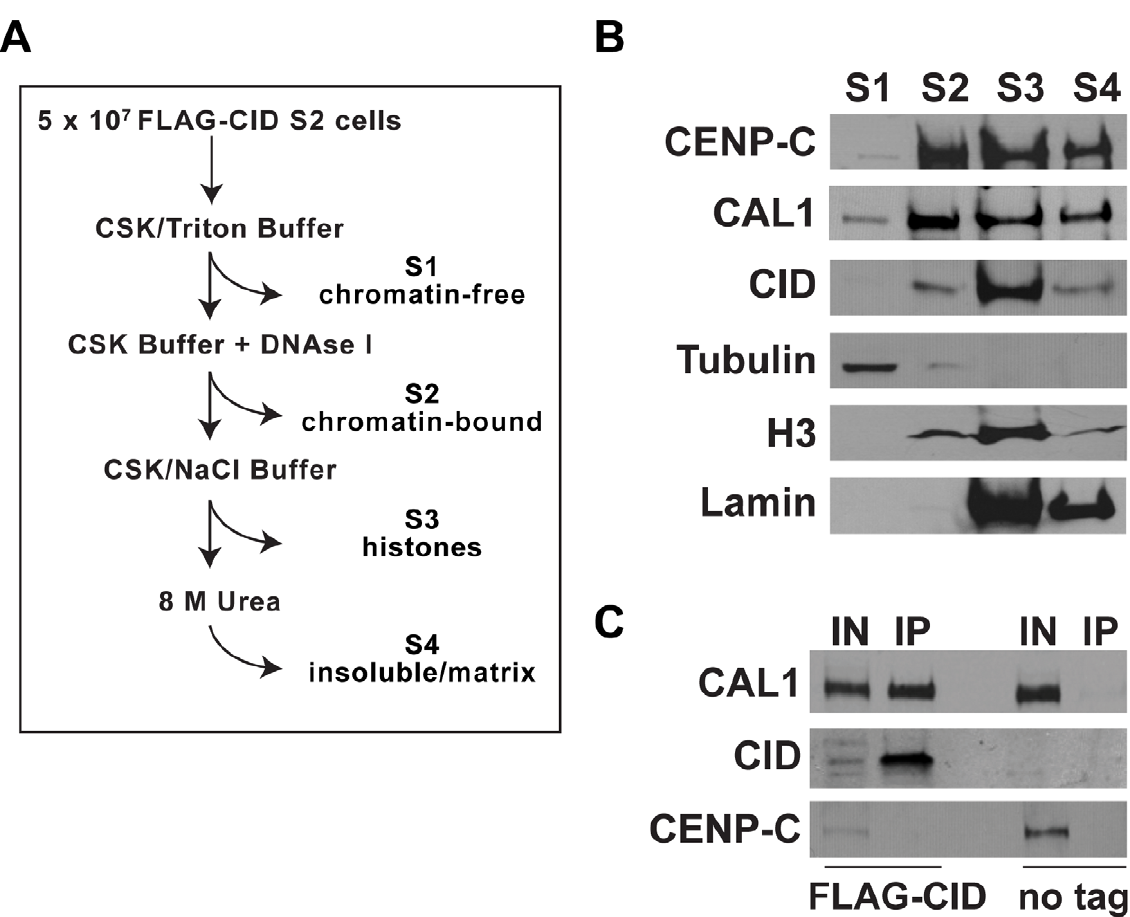
Figure 8. CAL1 and CID interact in chromatin-free extracts. A) Diagram depicting the cell fractionation method. B) Western blots to determine the presence of CAL1, CID and CENP-C in different cellular fractions. Chromatin-free (S1), nuclear-soluble (S2), chromatin-associated (S3) and insoluble/matrix-bound (S4) protein fractions were extracted from S2 cells stably transfected with FLAG-tagged CID. 40 m g of total protein was loaded in each lane. Antibodies against a -Tubulin, histone H3K4Me2 and Lamin were used to track the content of the different fractions (see Materials and Methods). C) Immunoprecipitation showing the specific interaction between FLAG-CID and CAL1 from the S1 fraction. The CID-CAL1 interaction was visible only in extracts from FLAG-CID expressing cells and not from untransfectd S2 cells (no tag). Soluble FLAG-CID did not pull down CENP-C. Chromatin-free extracts were incubated with 10 m l of FLAG-M2 agarose for two hours before elution of the bound CAL1 complex (IP) with 300 m g/ul of 3 6 FLAG peptide; 25% of the eluted material (IP) and 50 m g input material (IN) were